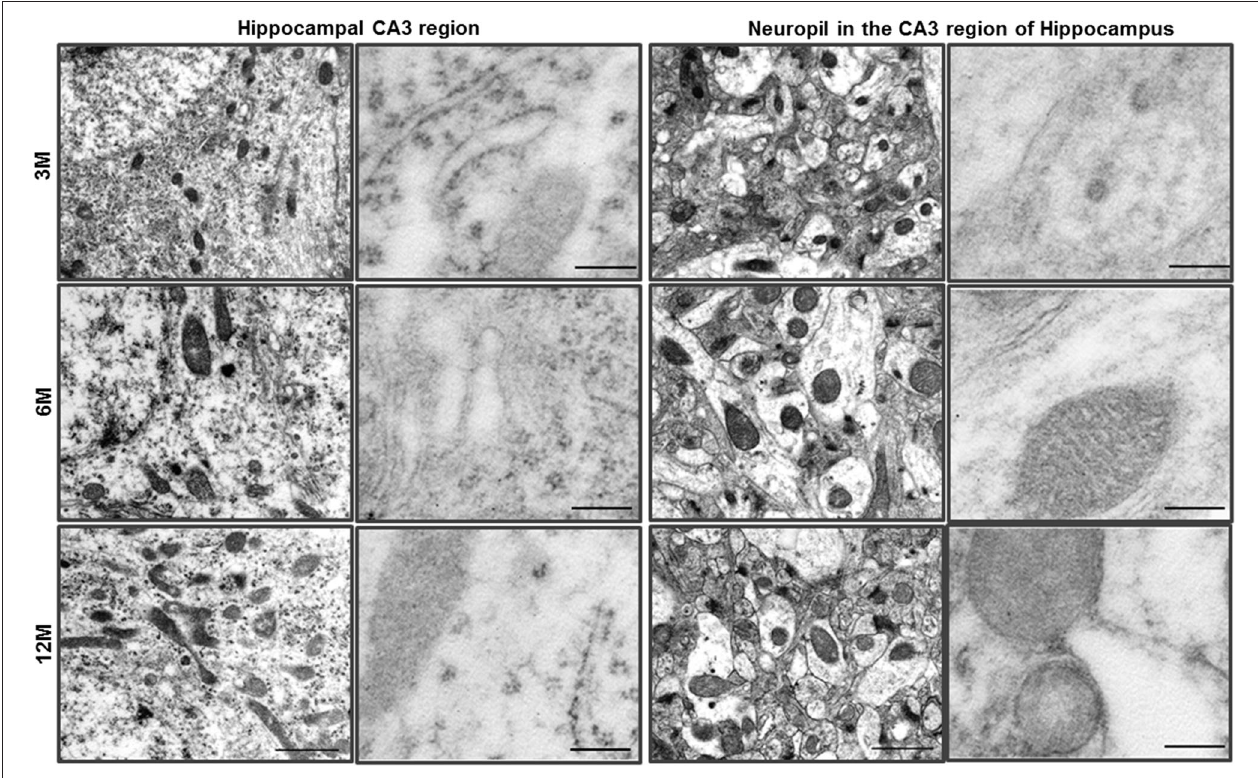
observed in the cytosol. The neuropil in the CA3 region of hippocampus exhibited normal neurites and mitochondria, and LC3B immunogold particles were not observed. Scale bars, 1 µ m for typical TEM; 200 nm for